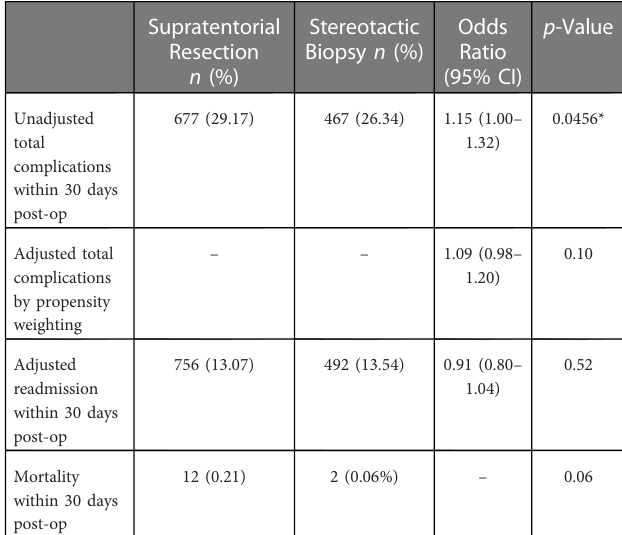
TABLE 2 Rates of postoperative complications associated with resection and biopsy.